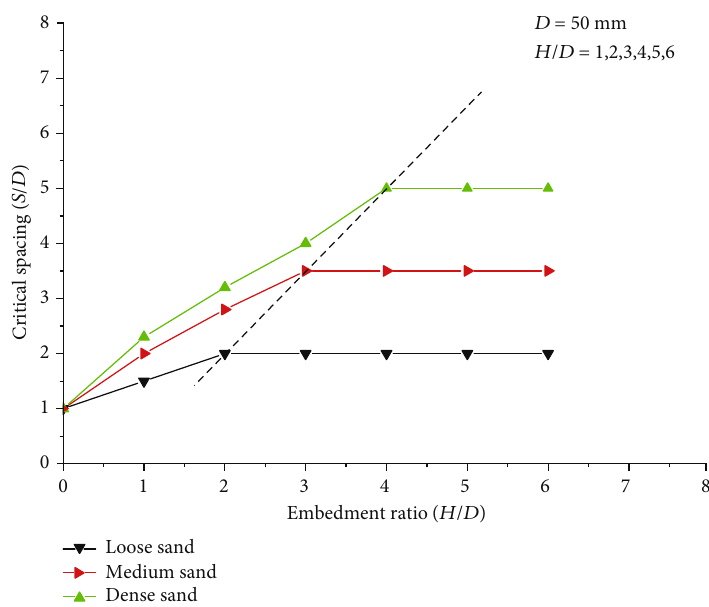
Figure 8: Relationship between critical spacing and the embedment ratio in